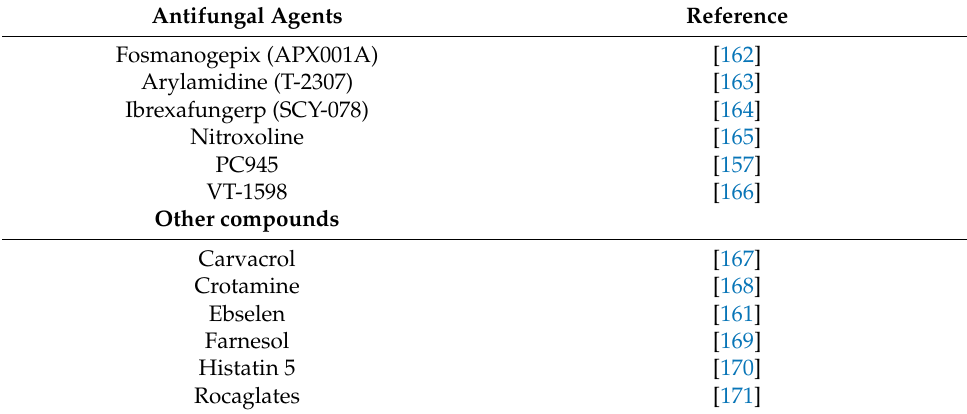
Table 2. Novel drugs, molecules, or compounds with proven activity against C. auris